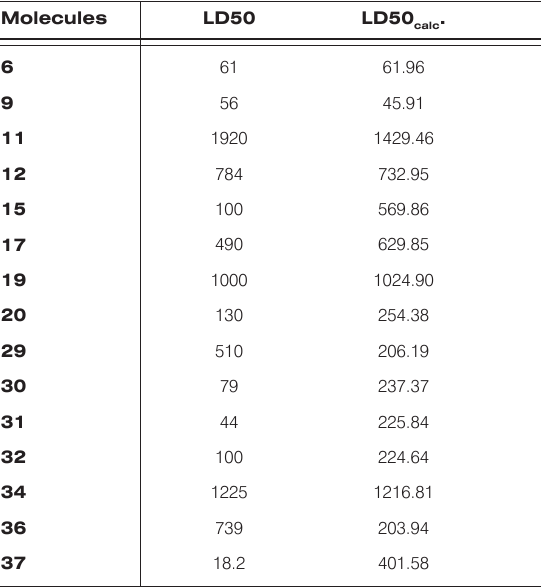
Table 9. Calculated values of LD50 for the molecules in the test set (Table 1).